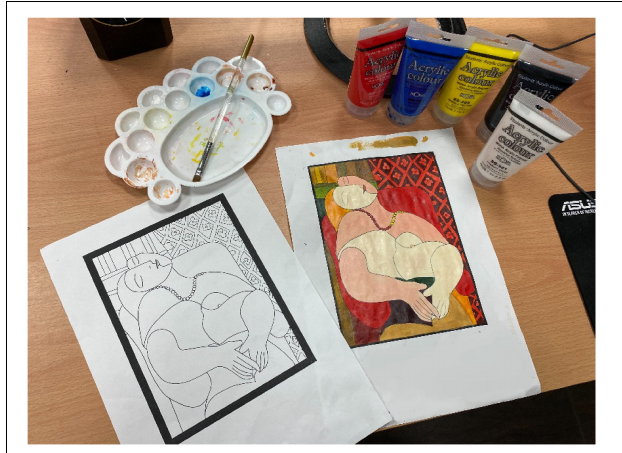
FIGURE 4 | Combining three primary colors (red, blue, yellow) of the pigments with black and white to make up for the shortcomings of the three primary